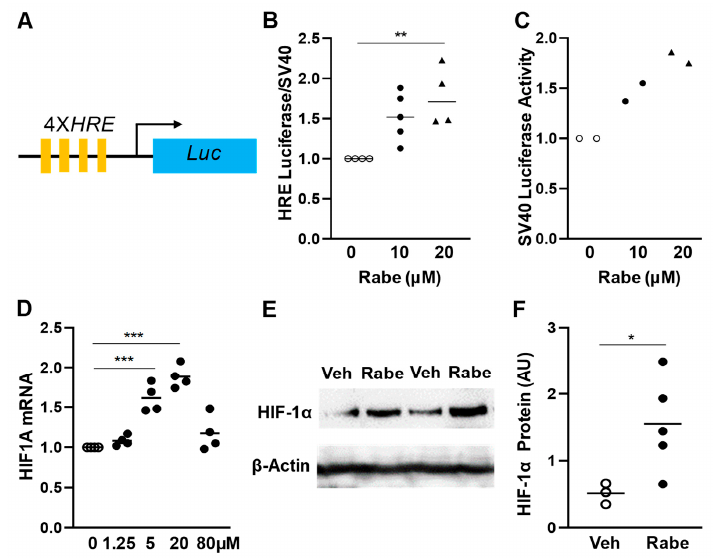
Figure 1. Rabeprazole is a HIF-1 α inducer. ( A ) Schematic representation of the plasmid DNA ex- pressing luciferase under the control of 4 hypoxia response elements (4XHRE) in 786-O cells. ( B , C ) Validation of Rabeprazole as an HIF- α activator in 786-O cells. Stable 786-O cells with 4XHRE or SV40 promoter luciferase plasmid were seeded in 384-well plates (500 cells/well). Rabeprazole at the indicated concentrations was added to the wells at 24 h after cell seeding. At 48 h later, lumines- cence signal was measured. Rabeprazole treatment resulted in marked increases in HRE luciferase activity without concomitant decreases in SV40 promoter-controlled luciferase activity, indicating Rabeprazole at the active dose had no toxic effect on the cells. ( D ) Rabeprazole induced HIF1A mRNA in HLMVECs, as shown by RT-qPCR analysis. HLMVECs were seeded into 6-well plates (0.3 × 10 6 cells/well). At 48 h later, Rabeprazole was added at the indicated concentrations. At 18 h post-treatment, cells were collected for molecular analyses. ( E , F ) Rabeprazole treatment increased HIF-1 α protein levels in lungs of LPS-challenged WT mice. At 4 and 20 h post-LPS (2.5 mg/kg, i.p.), mice were treated with PBS (Veh) or 20 mg/kg Rabeprazole (Rabe, oral). At 52 h post-LPS, lung tissues were collected for Western blotting ( E ) and quantifications of HIF-1 α protein levels ( F ). * p < 0.05, ** p < 0.01, and *** p < 0.001. One-way ANOVA with Bonferroni post-tests ( B , D ) or unpaired t - test ( F ).